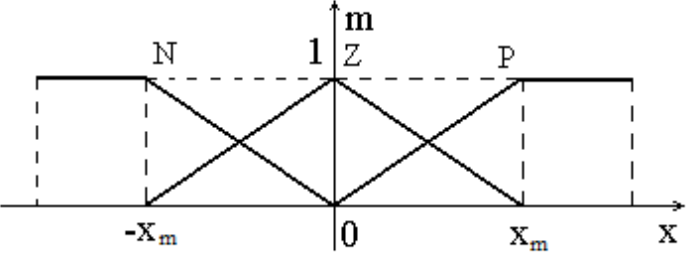
Figure 6. The membership functions for the fuzzy values of the fuzzy controller.